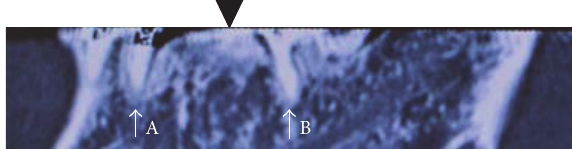
Figure 4: Sagittal computed tomographic image. Arrows: (A) the root of the lower left tooth #4 and (B) the root of the lower left tooth #8. Arrowhead: bone formation.